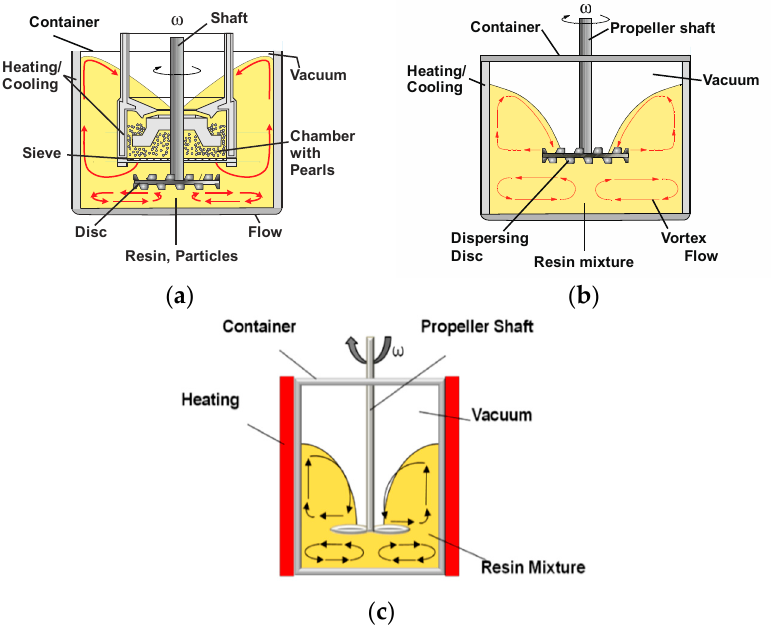
Figure 1. Different devices used for mixing process of nanocomposites ( a ) Torus mill ( b ) Dissolver and ( c ) Propeller aggregate [39].